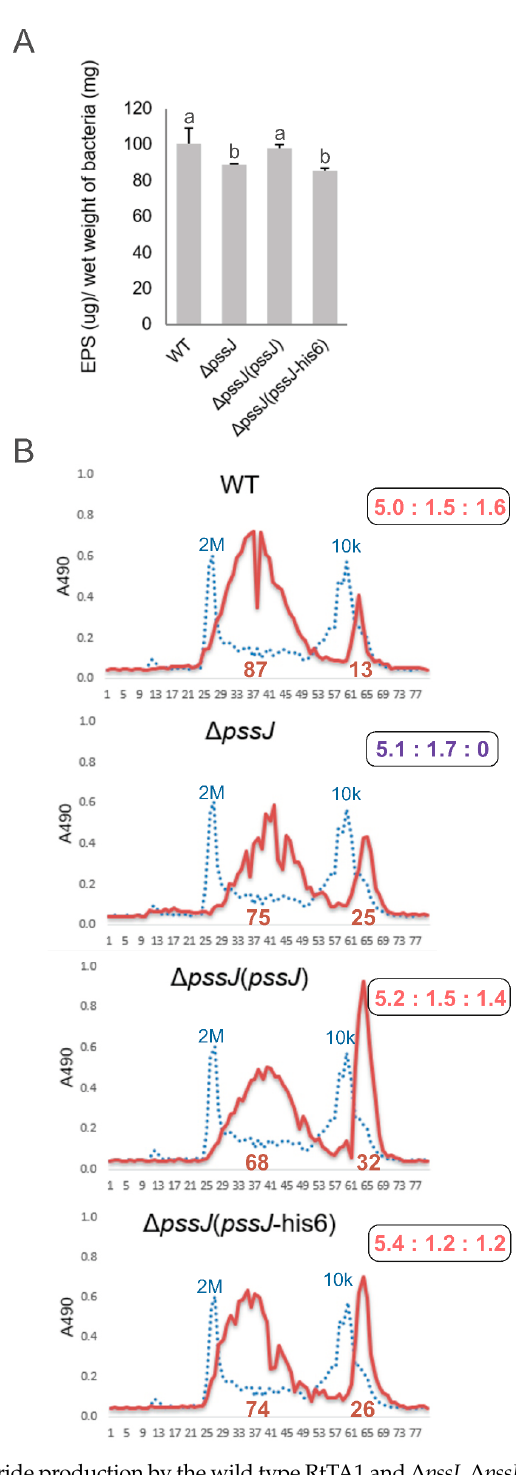
Figure 5. Exopolysaccharide production by the wild type RtTA1 and ∆ pssJ , ∆ pssJ ( pssJ ), and ∆ pssJ ( pssJ -his6) strains. ( A ) The total amount of EPS precipitated with 4 volumes of ethanol from the supernatants of cultures grown for 5 days in the 79CA medium containing 0.5% glycerol. Bars labeled with di ff erent letters represent values that are significantly di ff erent at p < 0.05. The amount of EPS is expressed as glucose equivalents. ( B ) Gel permeation chromatography of exopolysaccharides; the retention times of dextran blue (2 MDa) and dextran T10 (10 kDa) (molecular mass markers) are shown as blue dotted lines. Monosaccharide molar ratios in exopolysaccharides precipitated from supernatants are shown in the boxes on the right; the ratio specific for the mutant, indicating absence of galactose in EPS, is shown in dark blue.